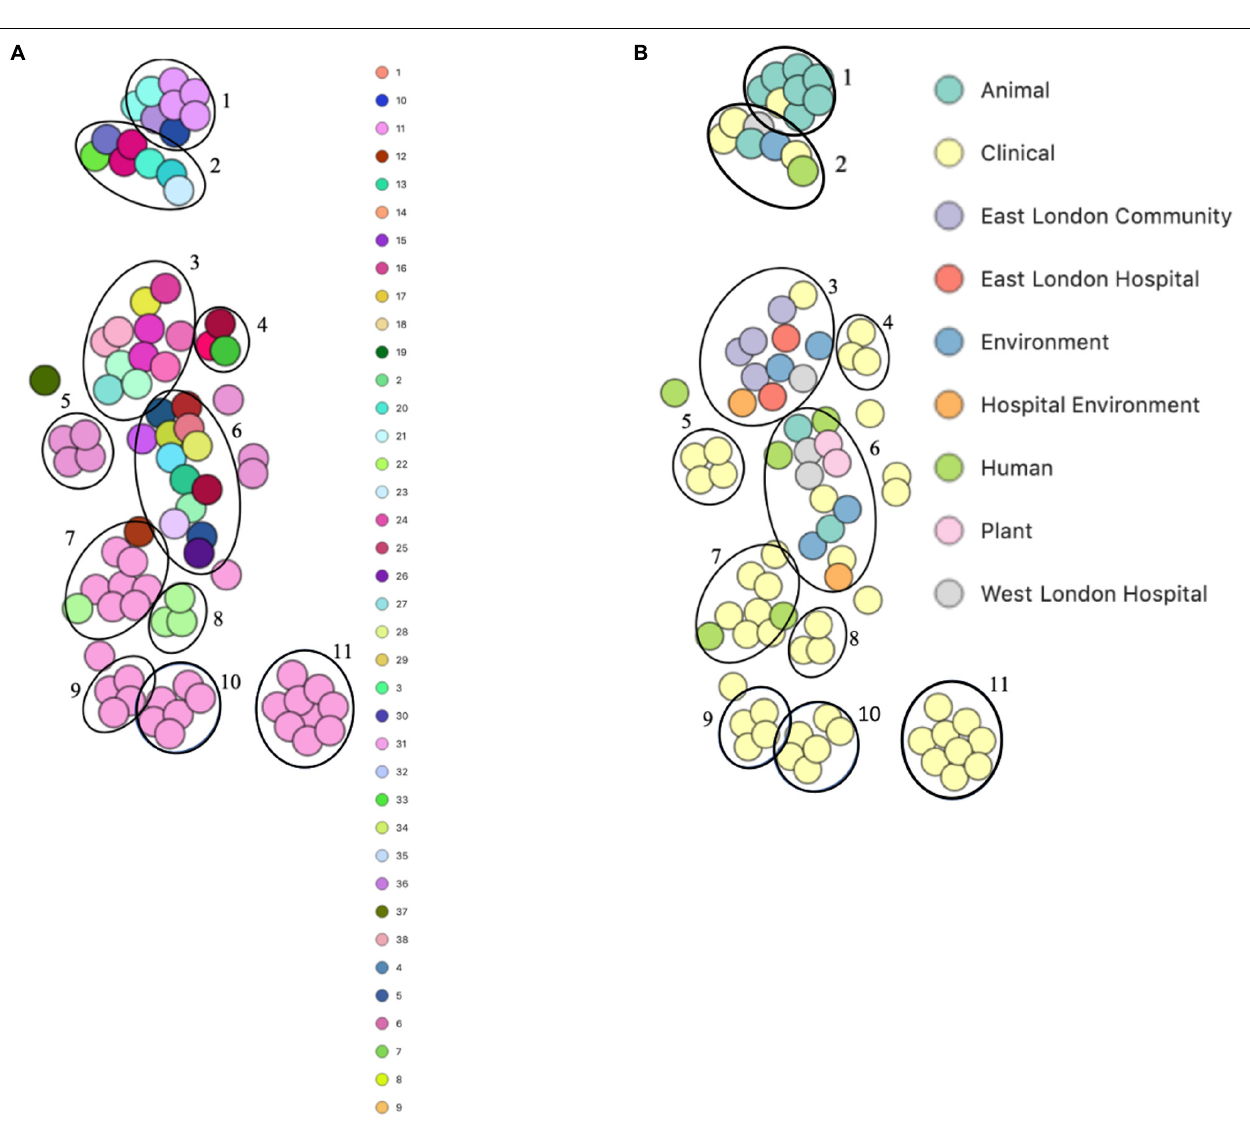
FIGURE 4 | PoPpunk t-SNE analyses of accessory genomes of 83 S. haemolyticus isolates. Analyses were performed using PopPUNK pipeline. The maximum number of mixture components was set at 4 and for the perplexity of t-SNE set at 15. (A) Combined core and accessory genome cluster from PopPUNK analyses; (B) isolation